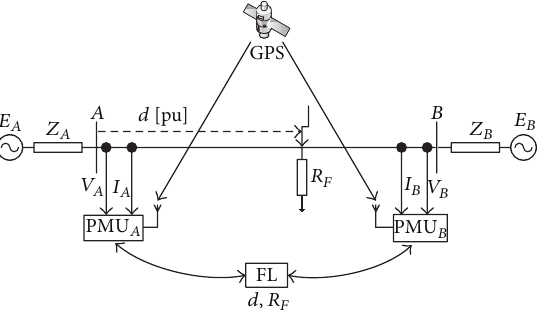
Figure 1: A schematic diagram for two-end synchronized fault- location arrangement using